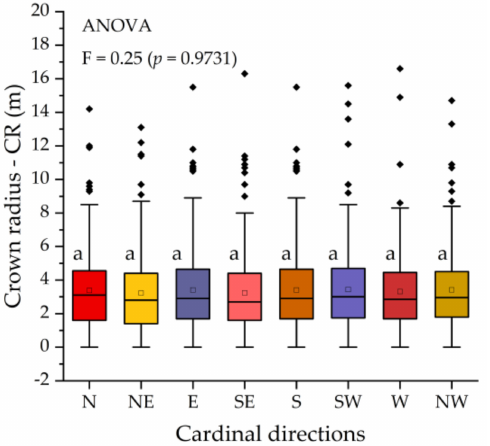
Figure 5. Box plot of crown radii according to their cardinal positions, in which N refers to north; NO, to northeast; E, to east; SO, to southeast; S, to south; SW, to southwest; W, to west; NO, to northeast. Letter “a” on the left side of the boxes is due to the Tukey test. Table 3. Spearman’s correlation values and variable importance used to model crown diameter. Spearman’s Correlation Random